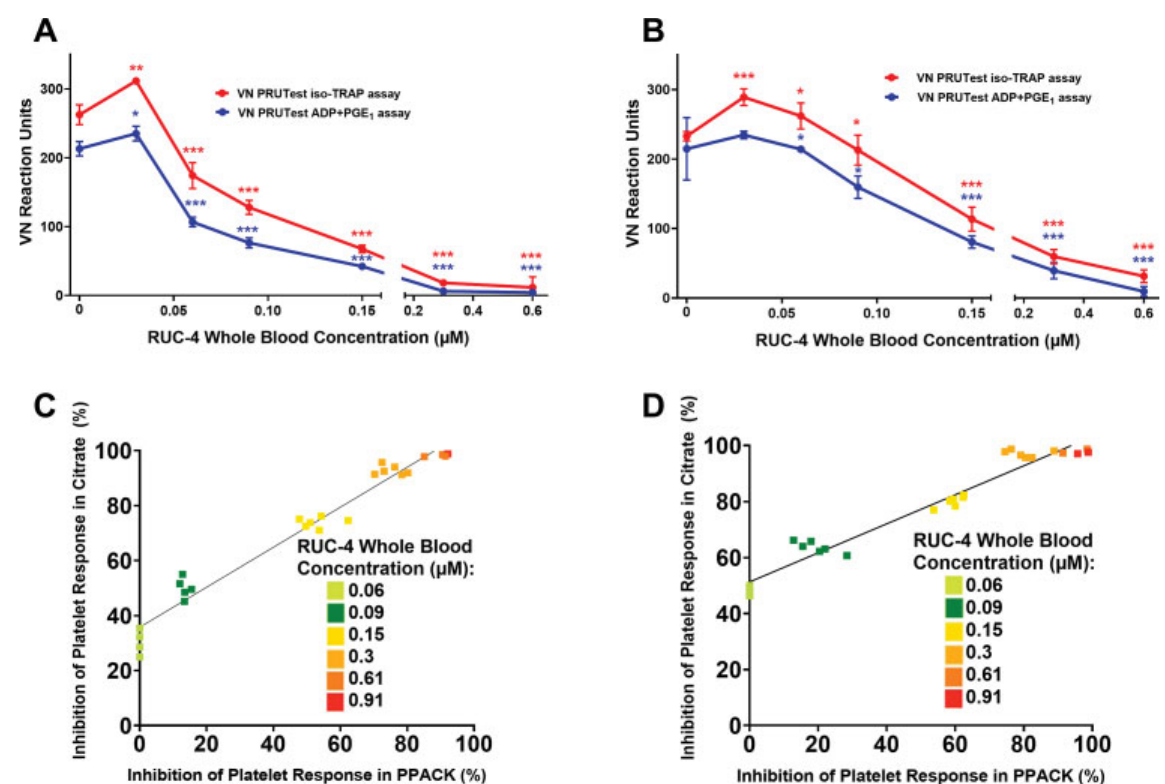
Fig. 1 In vitro RUC-4 concentration-response in inhibiting the VN iso-TRAP and ADP þ PGE 1 assays with blood from healthy volunteers not taking aspirin and anticoagulated with sodium citrate or PPACK. ( A ) Concentration-response curve in citrate-anticoagulated blood ( n ¼ 7), data are mean (cid:4) SD. ( B ) Concentration-response curve in PPACK-anticoagulated blood ( n ¼ 7), data are mean (cid:4) SD. ( C ) Percentage inhibition of response of iso-TRAP assay in PPACK- versus citrate-anticoagulated blood ( n ¼ 6; 25 measurements; R 2 ¼ 0.96; p < 0.001). ( D ) Percentage inhibition of response of ADP þ PGE 1 assay with PPACK- versus citrate-anticoagulated blood ( n ¼ 6; 25 measurements; R 2 ¼ 0.95; p < 0.001). (cid:6) p < 0.05 compared with control, (cid:6)(cid:6) p < 0.01 compared with control, (cid:6)(cid:6)(cid:6) p < 0.001 compared with control. VN ¼